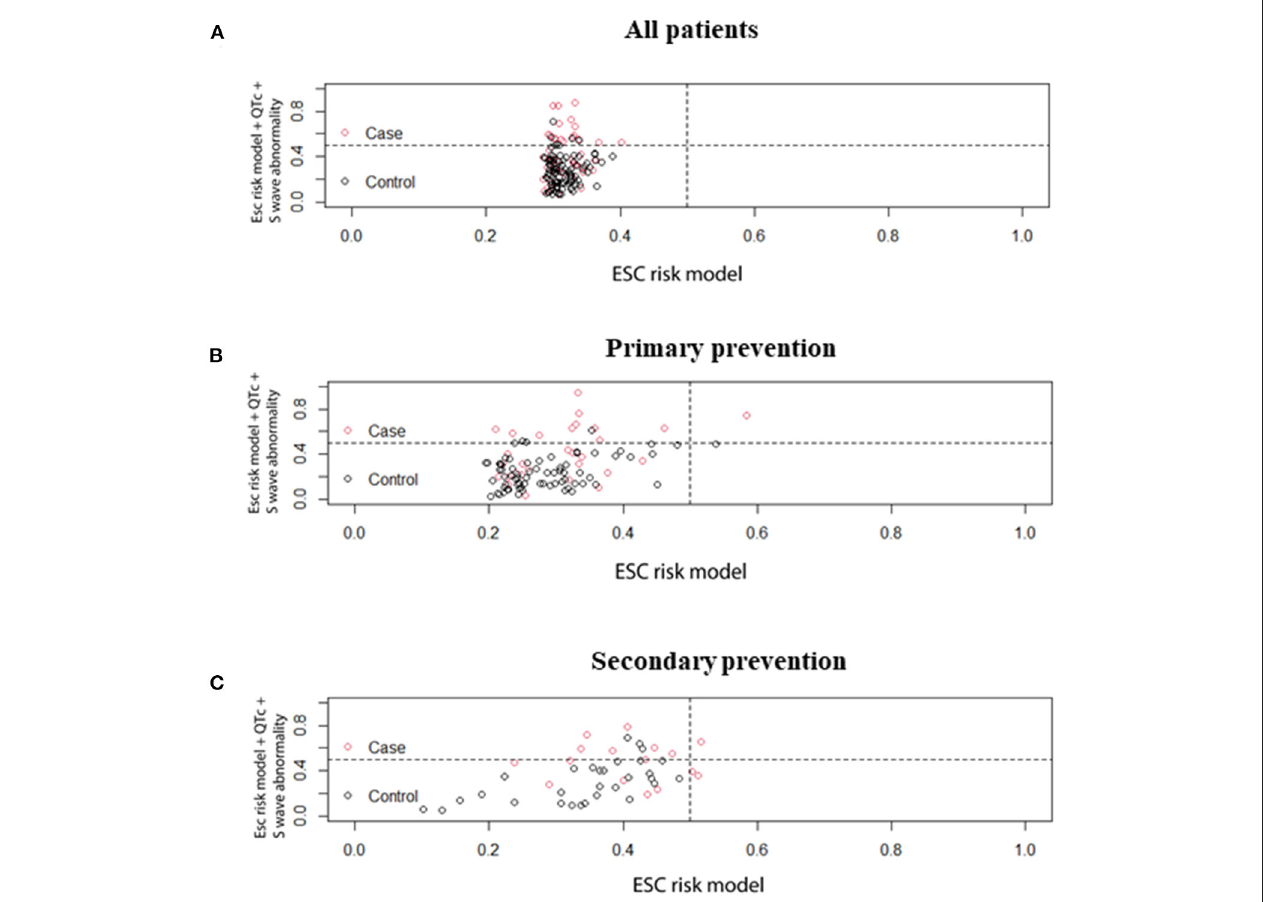
FIGURE 6 | Comparison of prediction effect of HCM-risk-SCD model before and after adding QTc and V4-S wave simultaneously. (A) for all patients, (B) for primary patients, and (C) for secondary patients. HCM, hypertrophic cardiomyopathy; SCD, sudden cardiac